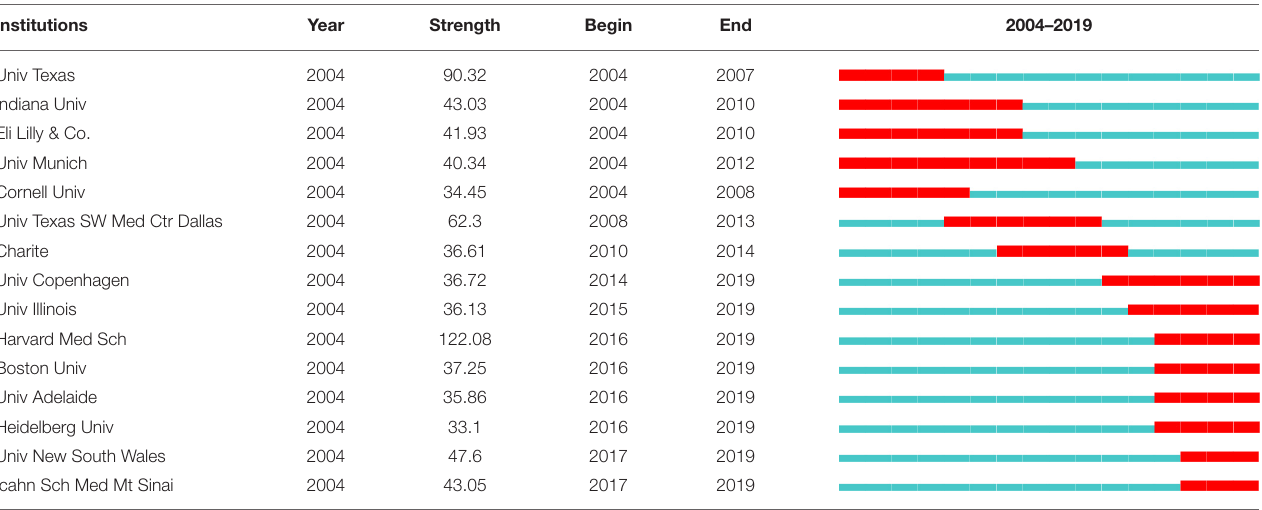
TABLE 6 | The top 15 institutions with the strongest citation bursts,